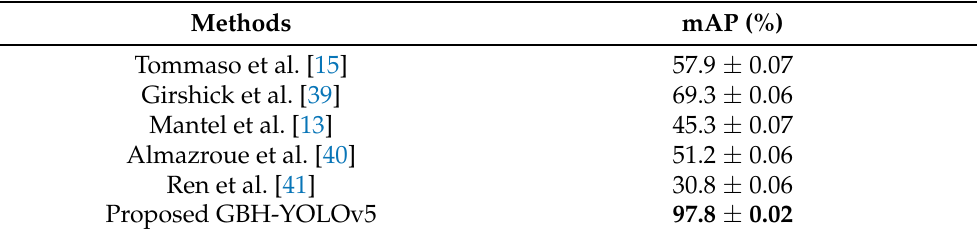
Table 3. The mAP performance of different methods on the Multi-Defect dataset, based on 95% confidence interval.